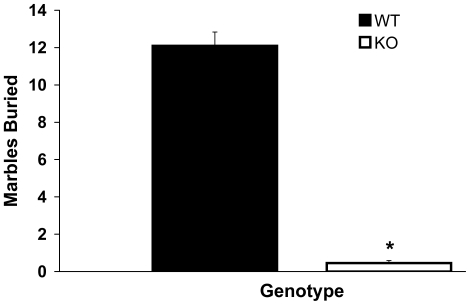
Marble Burying.5-HTT KO mice compared to WT mice buried significantly less marbles placed in a novel cage; *p<0.001. Error bars represent standard error of the mean.